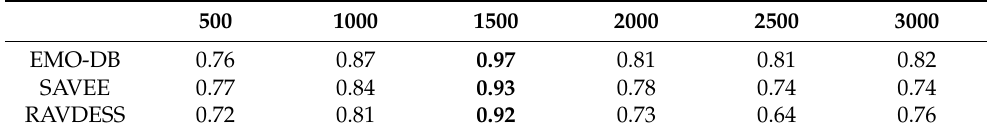
Table 3. Comparison of weighted accuracy (×100) at different binning